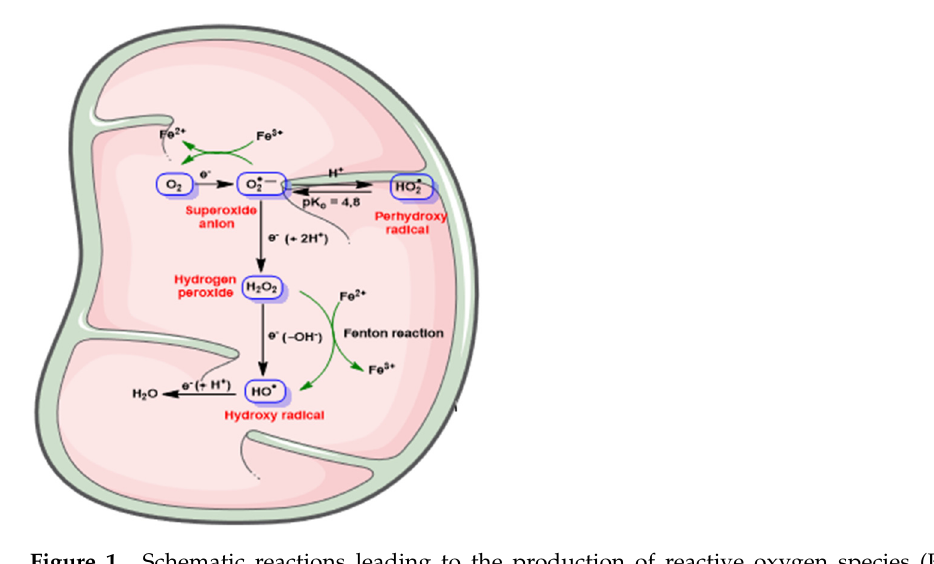
Figure 1. Schematic reactions leading to the production of reactive oxygen species (ROS) in the mitochondria.